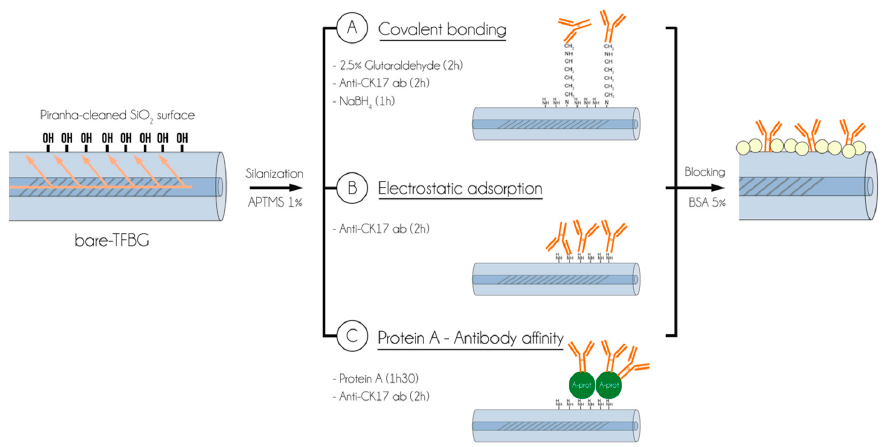
Figure 1. Illustration of the main steps of the three functionalization processes used for the immobilization of antibodies onto silica optical fibre gratings. The first method considered is a covalent binding of anti-CK17 antibodies ( A ) while electrostatic adsorption ( B ) and the use of Protein A intermediate are also represented ( C ).